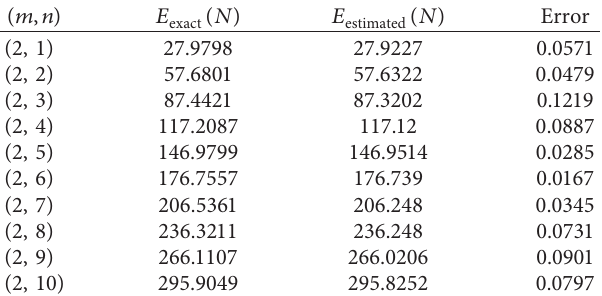
( N ) and E ( N ) values of the naphthalene. exact estimated